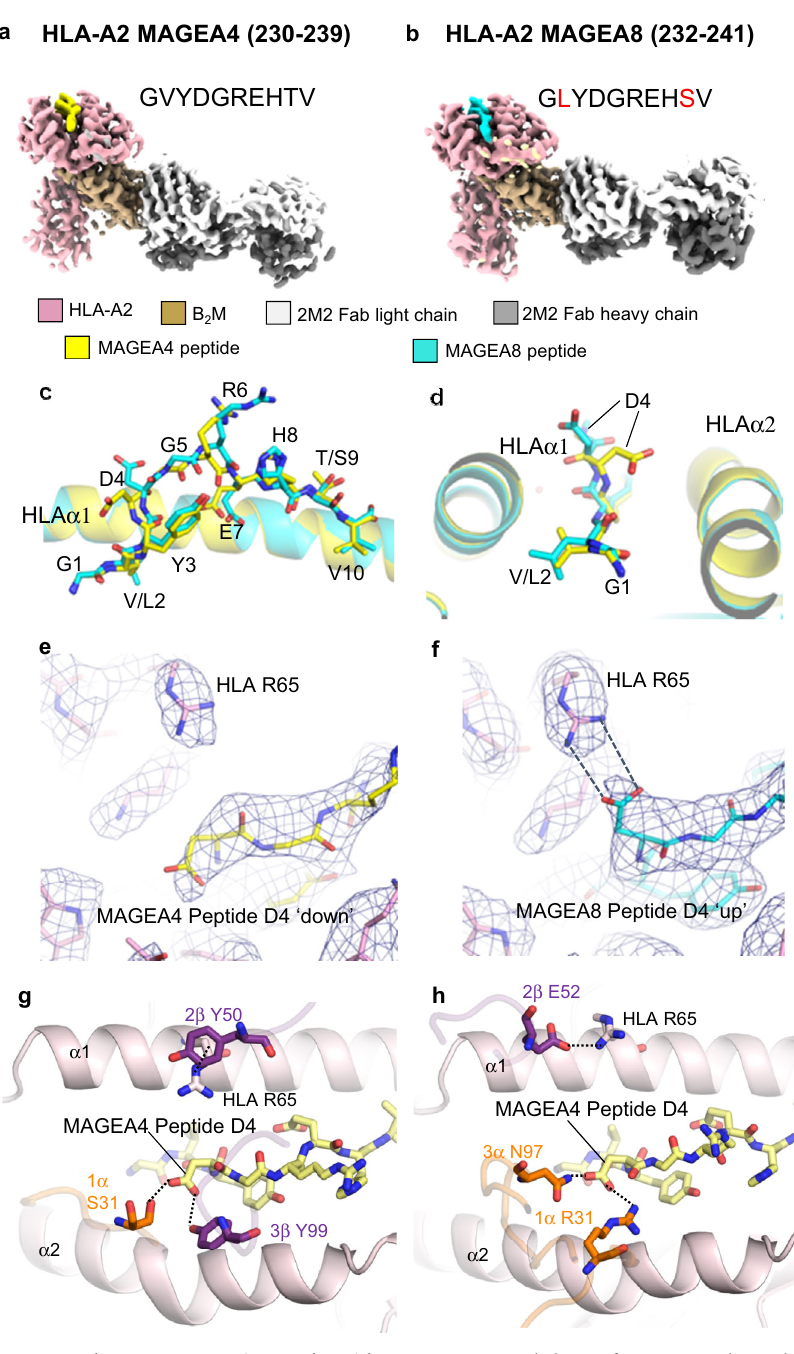
Fig. 5 | CryoEM structures of MAGEA4 and MAGEA8 pMHCs in complex with 2M2 Fab show distinct MHC-displayed peptide conformations. a , b cryoEM reconstructions of MAGEA4 and MAGEA8 pMHC complexes with 2M2 Fab, with polypeptide chains shown in different colors. Sequence differences between the two peptides are highlighted red in b . c , d two different views of the structural alignmentofMAGEA4(yellow)andMAGEA8(cyan)peptidesembeddedintheHLA